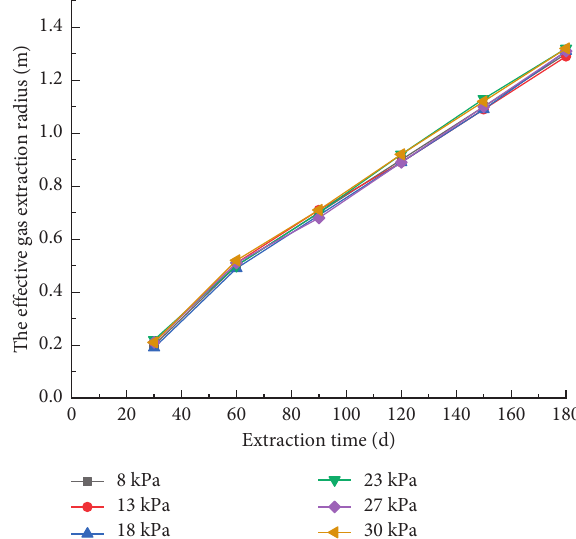
Figure 3: Change of gas pressure with extraction negative pressure after 60d of drainage.